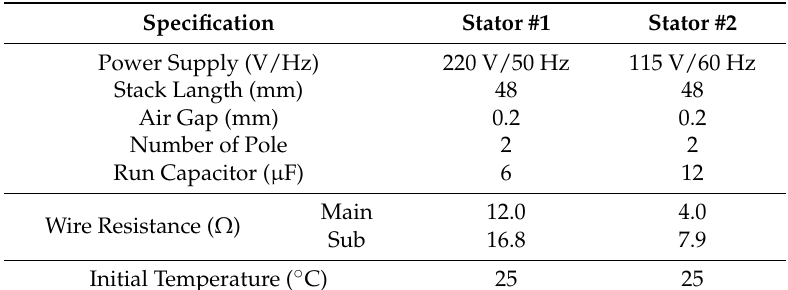
Table 5. The specifications of the prototype stators.